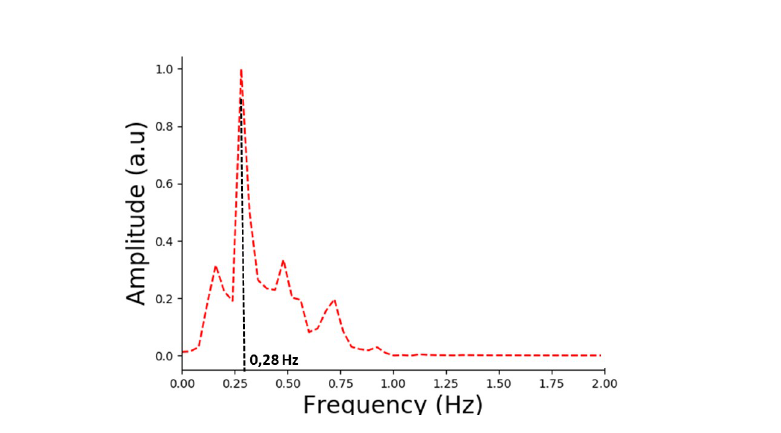
Figure 9. Output of fast Fourier transform for breath measurements. Table 2. Breathing cycle (BC), breathing frequency (BF), and breathing rate (BR) were measured for four volunteers with different weight (W) and height (H) during 30 s. The number and the rate of breath were chosen by the volunteers. BPM: